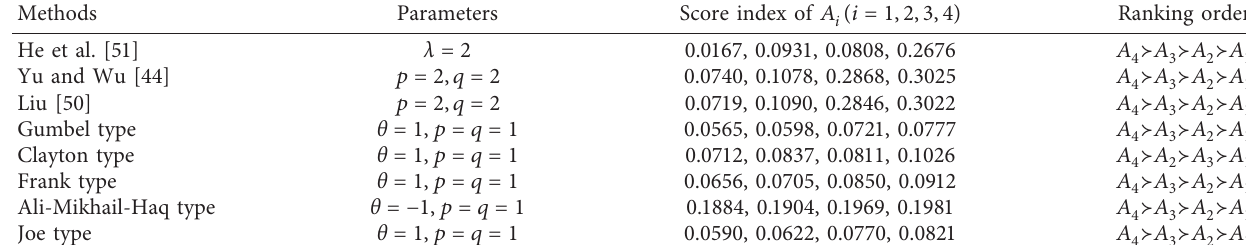
Table 7: Comparison with existing approaches for Example 2.